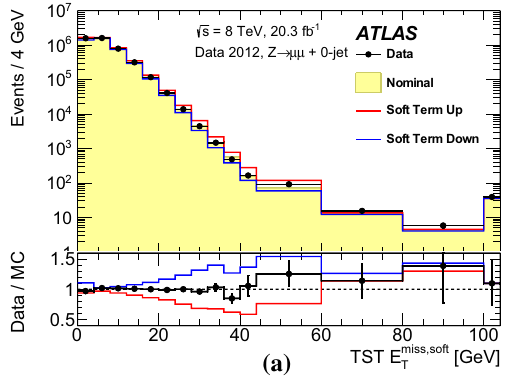
A separate systematic uncertainty is applied to the scalar summed p T of tracks associated with high- p T jets in the because these tracks are not included in the TST. Track E miss T The fraction of the momentum carried by charged particles within jets was studied in ATLAS [57], and its uncertainty varies from 3 to 5% depending on the jet η and p T . These uncertainties affect the azimuthal angle between the Track E miss and the TST E miss , so the modelling is checked with T T Z → μμ events produced with one jet. The azimuthal angle and the TST E miss directions is between the Track E miss T T well modelled, and the differences between data and MC simulation are within the systematic